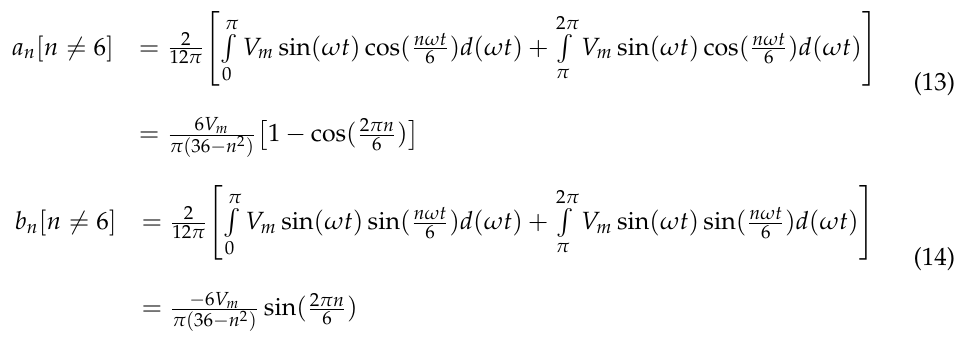
Figure 4. Output RMS voltage control through on-off cycle control. The average value a 0 is zero as the load is connected and disconnected for an integer number of cycles that makes this wave symmetrical along the y-axis. But, Figure 4 depicts that the periods of the output and input waveforms are unequal. To be specific, the period of the output voltage with a number of one ‘on-cycle’ and five ‘off-cycles’ is 12 π , i.e., 2 π ( k + l ). But the period of the input waveform is 2 π . Here the output pulse is selected for six ( k + l ) cycles of the input for harmonics contents. The other Fourier coefficients based on PSA are realized in Equations